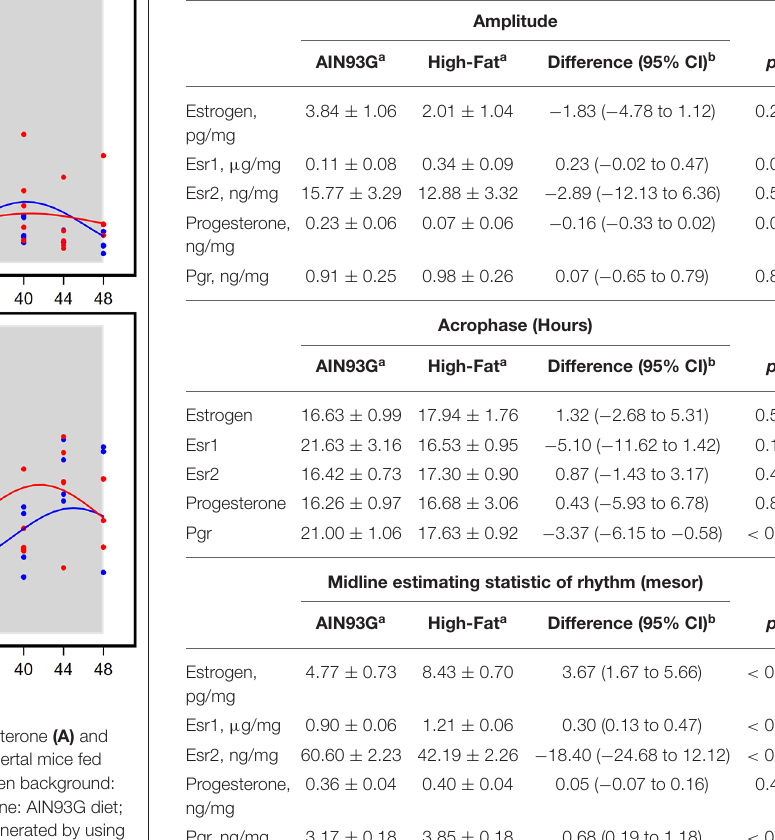
TABLE 4 | Estimated values from the Cosinor model of concentrations of estrogen, progesterone, and their receptors in mammary glands from pubertal mice fed AIN93G or high-fat diet.